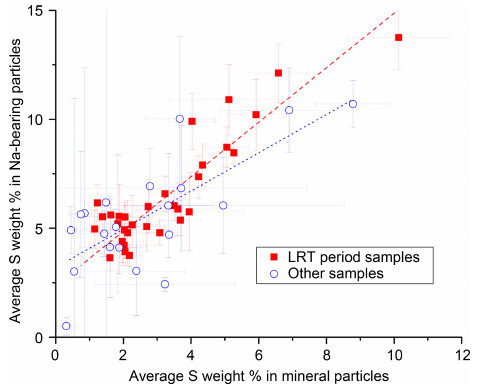
Figure 13. The relation between average S weight percent in sea- salt and mineral particles within LRT periods (open red squares) and other (blue circles) samples. Coefficients of R 2 of determination were 0.80 and 0.51 for the LRT period (red dashed line) and other samples (blue dotted line),